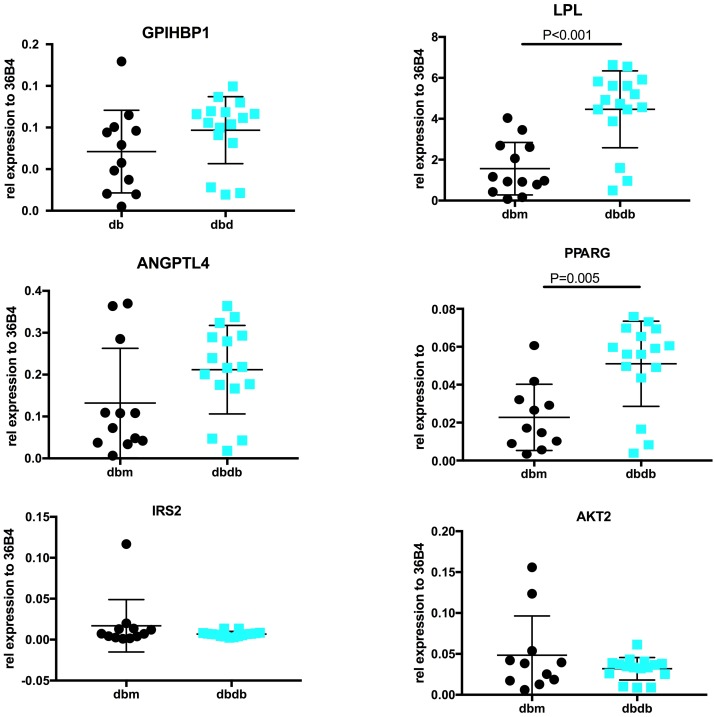
mRNA expression of genes involved in peripheral lipolysis in visceral adipose tissue lysates from Leprdb/m and Leprdb/db mice.Visceral adipose tissue was harvested from Leprdb/m and Leprdb/db mice (n = 8 per group). A. mRNA expression of Gpihbp1, Lpl,Angptl4, Pparg, Irs2 and Akt2. Relative expression was determined using 36B4 as the housekeeping gene.